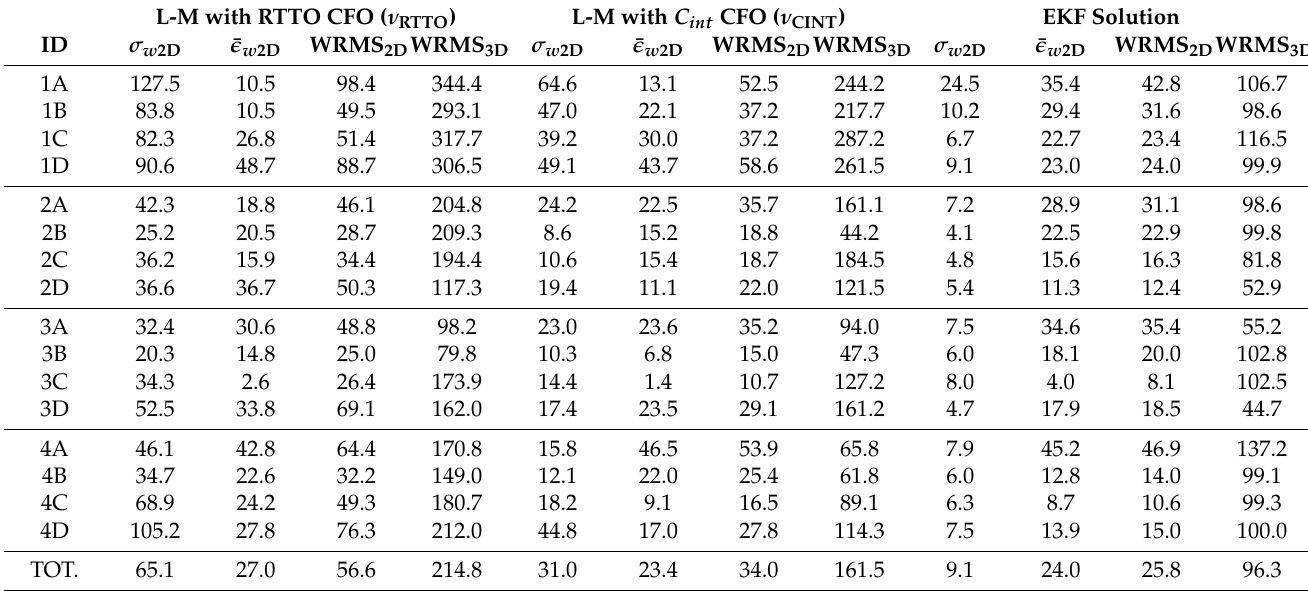
Table 2. Weighted statistics of 3D position estimates (all values in